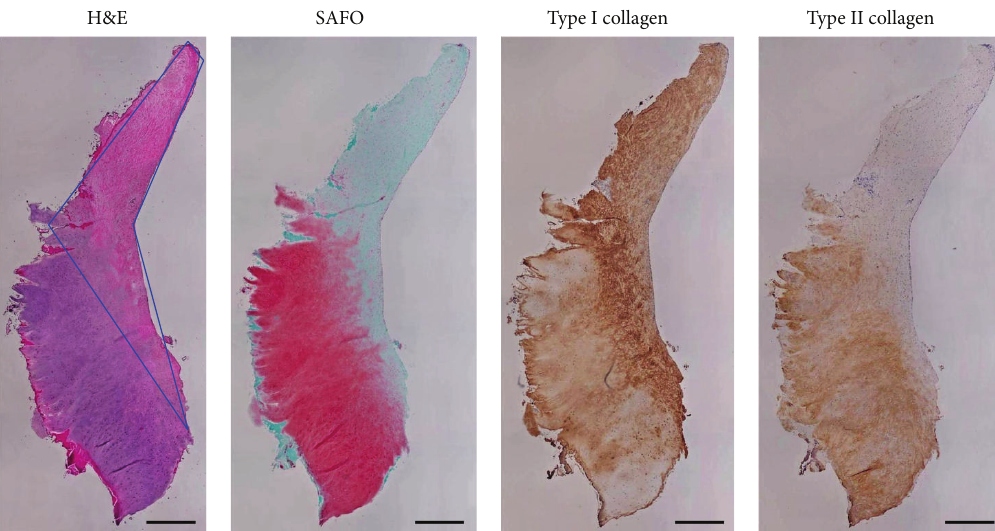
Figure 7: Histological stains after marrow stimulation. Histological stains of cartilage repair tissue collected from 43-year-old patient 8.2 months after marrow stimulation surgery that required revision. Section outlined in blue in H&E stain is fibrocartilage, while the remaining tissue is primarily hyaline-like cartilage. Scale bars = 500 𝜇